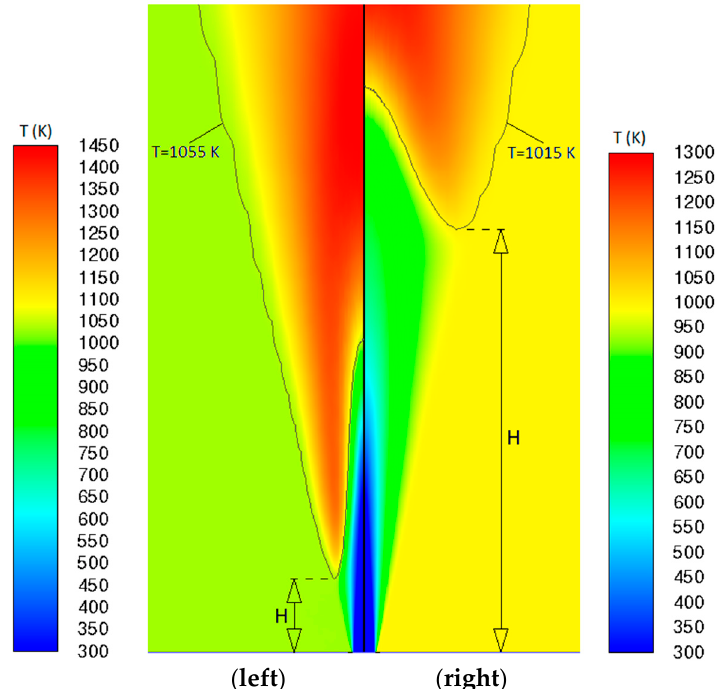
Figure 7. Temperature field distributions and isotherms predicted by G2-PDF with indication of lift-off heights ( left ) for T CO = 1050 K, with isotherm T = 1055 K, ( right ) for T CO = 1010 K, with isotherm T = 1015 K.